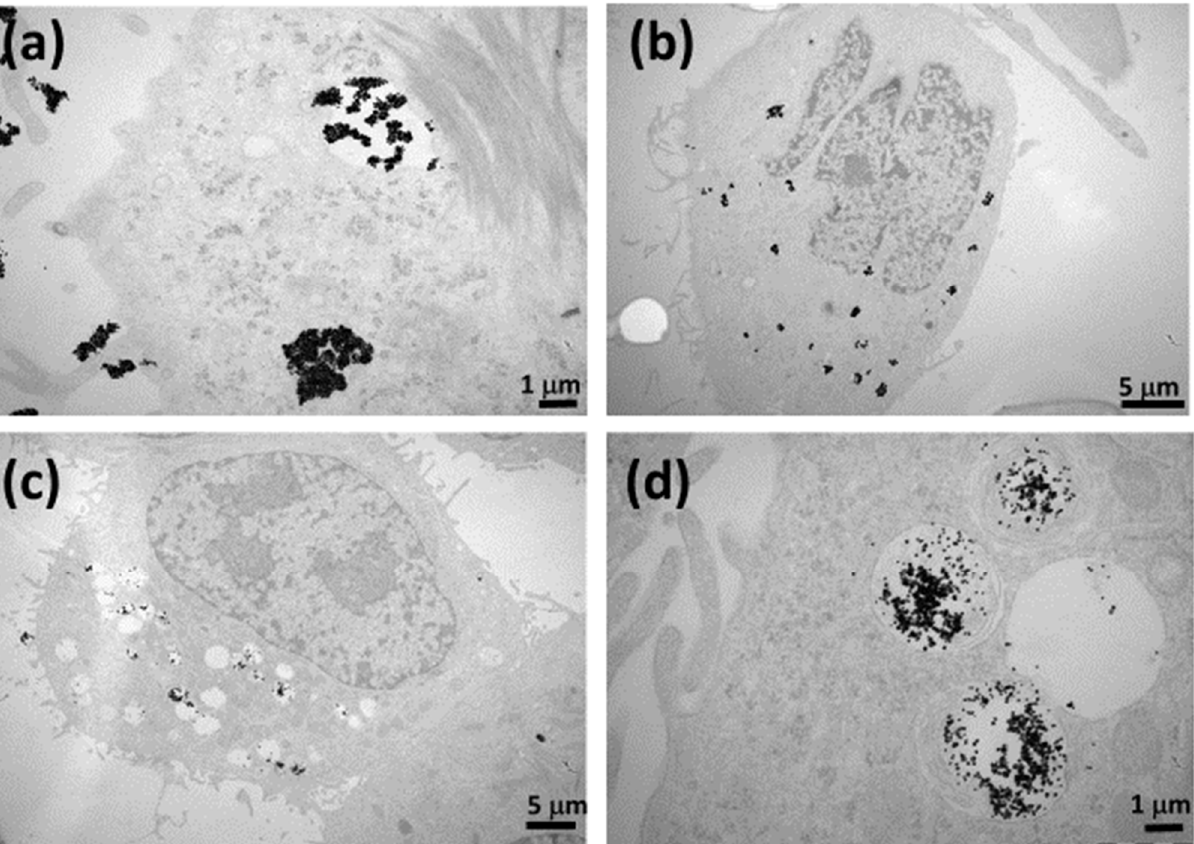
Figure 6. TEM images of the subcellular internalization of 21 μ M concentration of curcumin–piperine gold nanogels in U- 251 MG glioma cells; ( a ) curcumin–piperine NG interacting with the cell membrane and in a process to be up-taken by lysosome after 24 hours of exposure; ( b ) curcumin–piperine NG is residing with the membrane-bound compartment after 48 hours of exposure; ( c ) curcumin–piperine NG showing dissolved morphology and molecular dispersions found inside the cell cytoplasm after 72 hours of exposure; ( d ) magnified image of curcumin–piperine NG residing with the membrane- bound compartment after 72 hours of exposure.